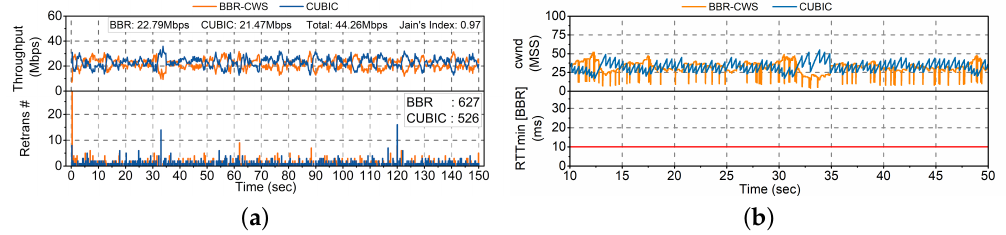
Figure 11. BBR-CWS vs. CUBIC (shallow buffer: 0.5 BDP): ( a ) throughput and retransmission; and ( b ) cwnd and RTprop of BBR-CWS.